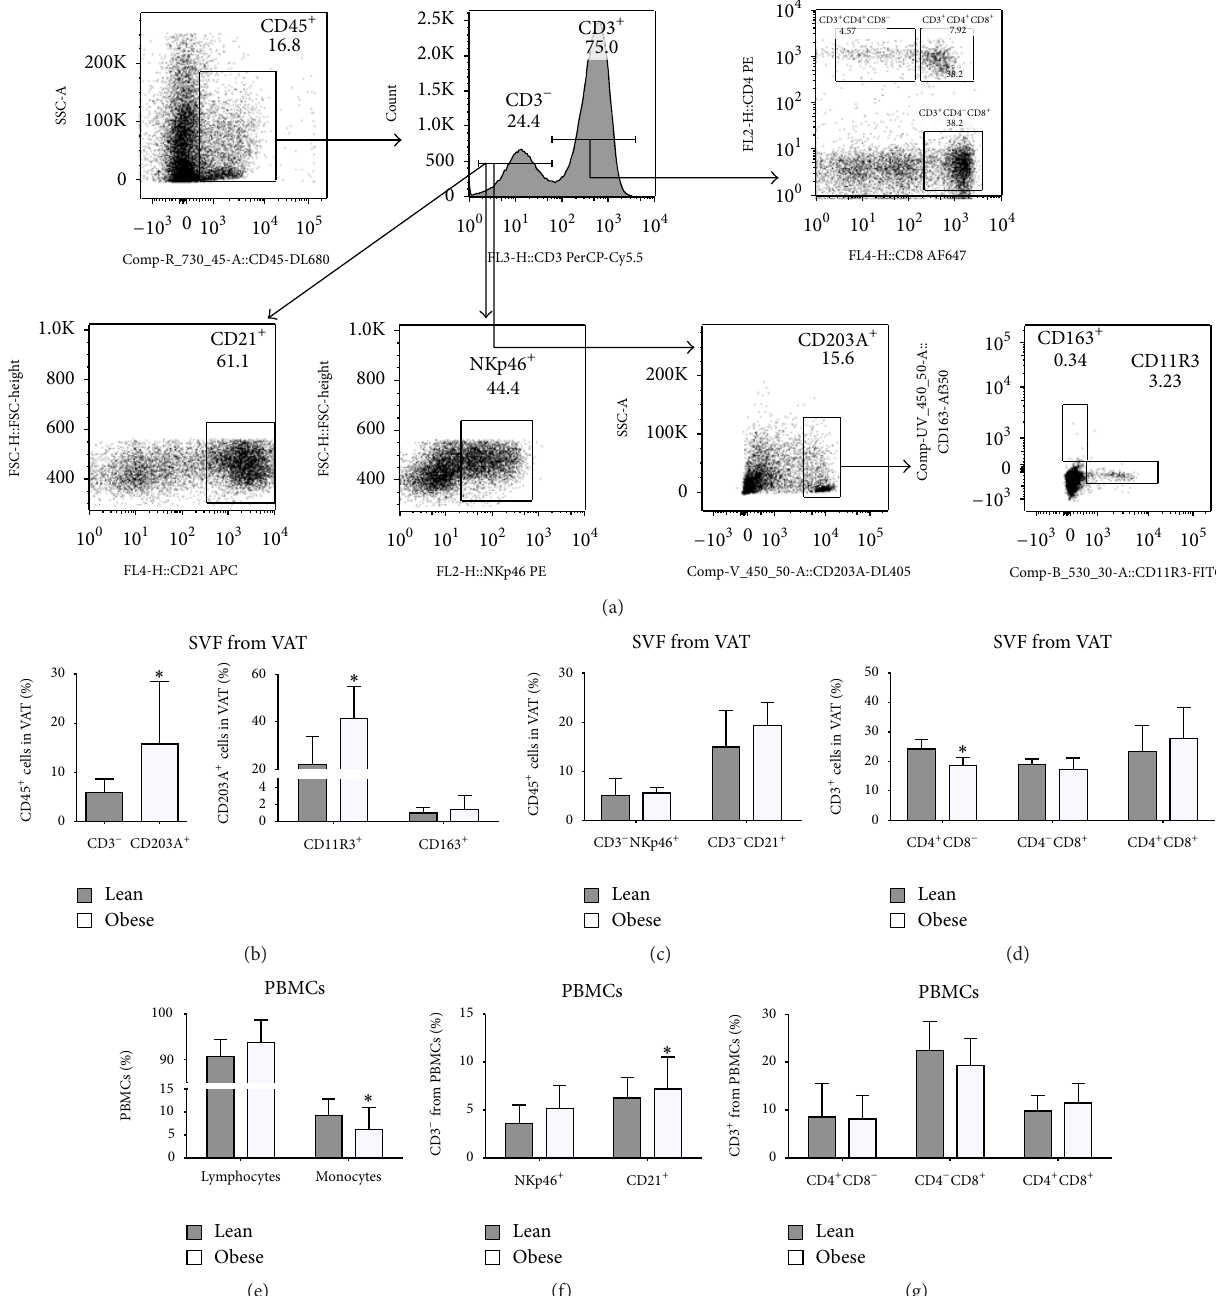
Figure 2: Phenotypic characterisation by flow cytometry of the adipose SVF cells and PBMCs in lean and obese pigs. (a) Gating strategy of the porcine adipose SVF cells from an obese pig. T-cells were defined as CD45 + CD3 + . Within the T-cells, CD4 + , CD8 + , and CD4 + CD8 + were characterised based on positivity for CD4 and CD8. Macrophages were defined as CD45 + CD3 − CD203A + , and the M1 and M2 macrophages were determined based on positivity for CD11R3 and CD163, respectively. B-cells were CD45 + CD3 − CD203A − and CD21 + whereas NK-cells were CD45 + CD3 − CD203A − and NKp46 + . (b–d) Infiltrating leukocyte populations in the adipose tissue within the CD45 + population from lean (grey columns) and obese (white columns) pigs. (b) Frequency of the total macrophages (CD203A + ), classically activated M1 macrophages (CD203 + CD11R3 + ), and alternatively activated M2 macrophages (CD203 + CD163 + ). (c) Frequency of natural killer cells (NKp46 + ) and B-cells (CD21 + ). (d) Frequency of the T-helper (CD3 + CD4 + ), T-cytotoxic (CD3 + CD8 + ), and double positive T-cells (CD3 + CD4 + CD8 + ) within the T-cells. (e–g) PBMCs subpopulation frequencies. (e) Lymphocytes and monocytes. (f) Natural killer cells (CD3 − NKp46 + ) and B-cells (CD3 − CD21 + ) populations frequency. (g) Frequency of the T-helper (CD3 + CD4 + ), T-cytotoxic (CD3 + CD8 + ), and double positive T-cells (CD3 + CD4 + CD8 + ) within the T-cells. Data are mean ± SD. ∗ 𝑝 < 0.05